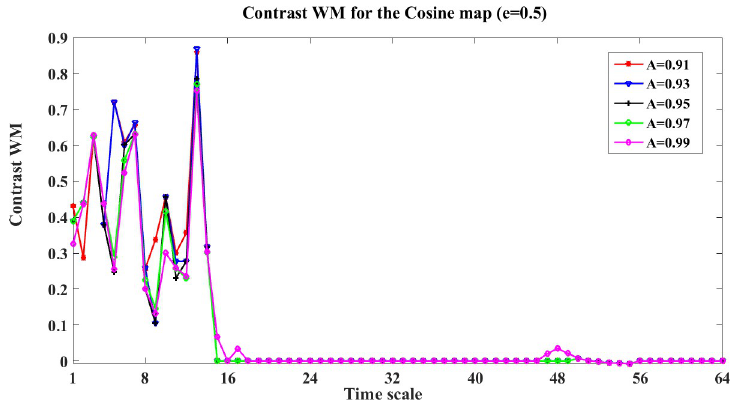
Fig 1. The contrast WM for the Cosine map at different stopping criteria A (e = 0.5). This figure shows the contrast WM O WM , X ! Y ( s i , e ) = WM C , X ! Y ( s i , e ) − WM C , Y ! X ( s i , e )(i = 1,2, ... 64,e = 0,0.1,0.2, ... ,1) for the cosine map (coupling e = 0.5). The curves with different colors represent the contrast WM at different stopping criteria (A = 0.91, 0.93,0.95,0.97,0.99).